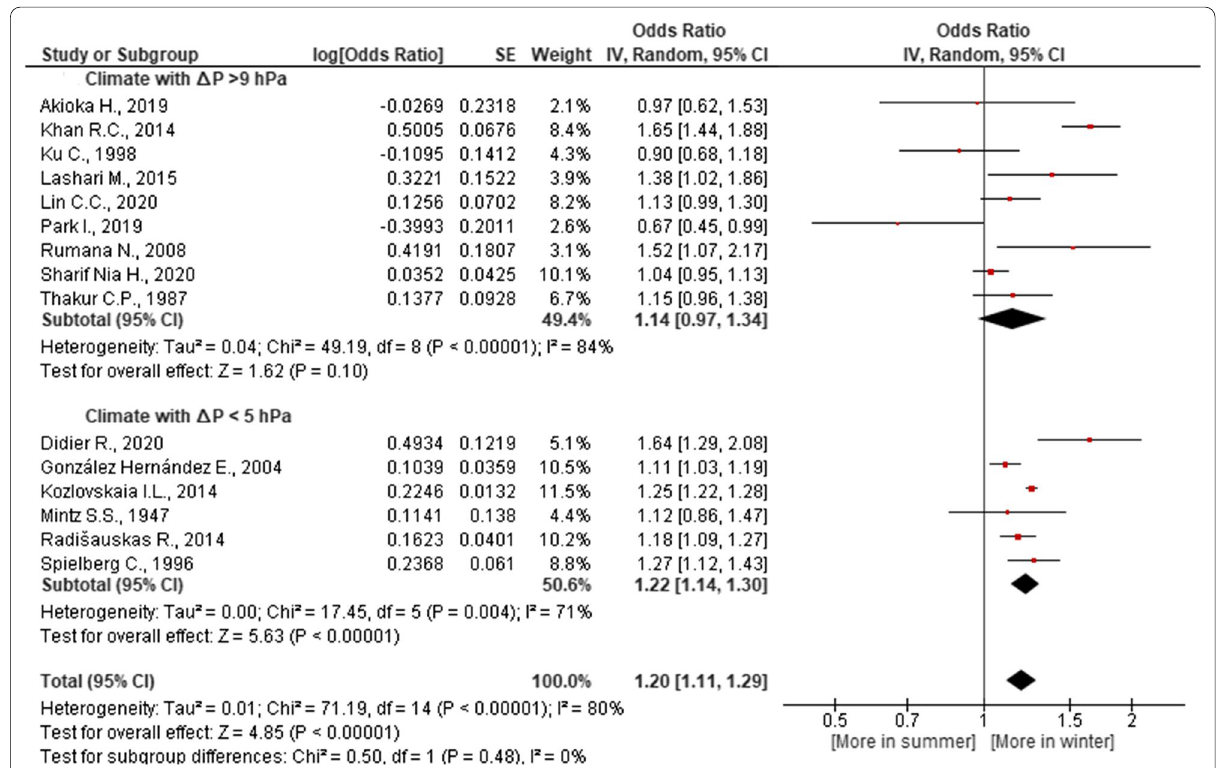
Fig. 3 Association of seasonal risk of myocardial infarction with atmospheric pressure